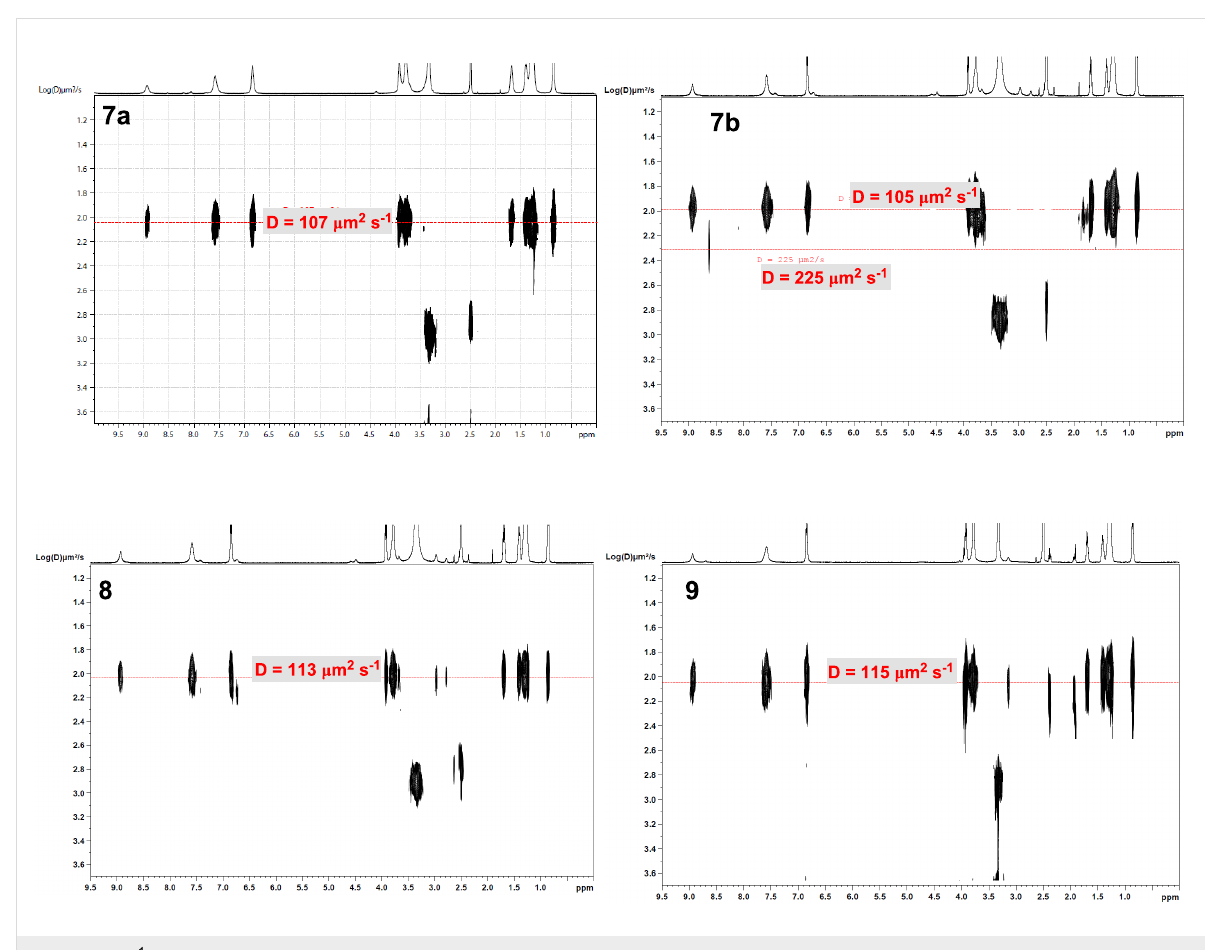
Figure 5: 2D- 1 H-DOSY NMR charts (DMSO- d 6 , 500 MHz, 298 K) of compounds 7a , 7b (2.5 mM), 8 and 9 (5.0 mM).